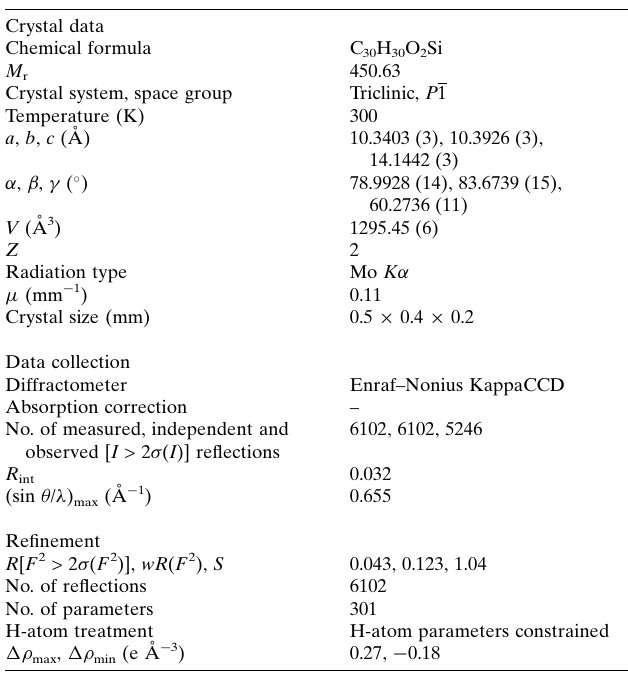
Table 2 Experimental details.